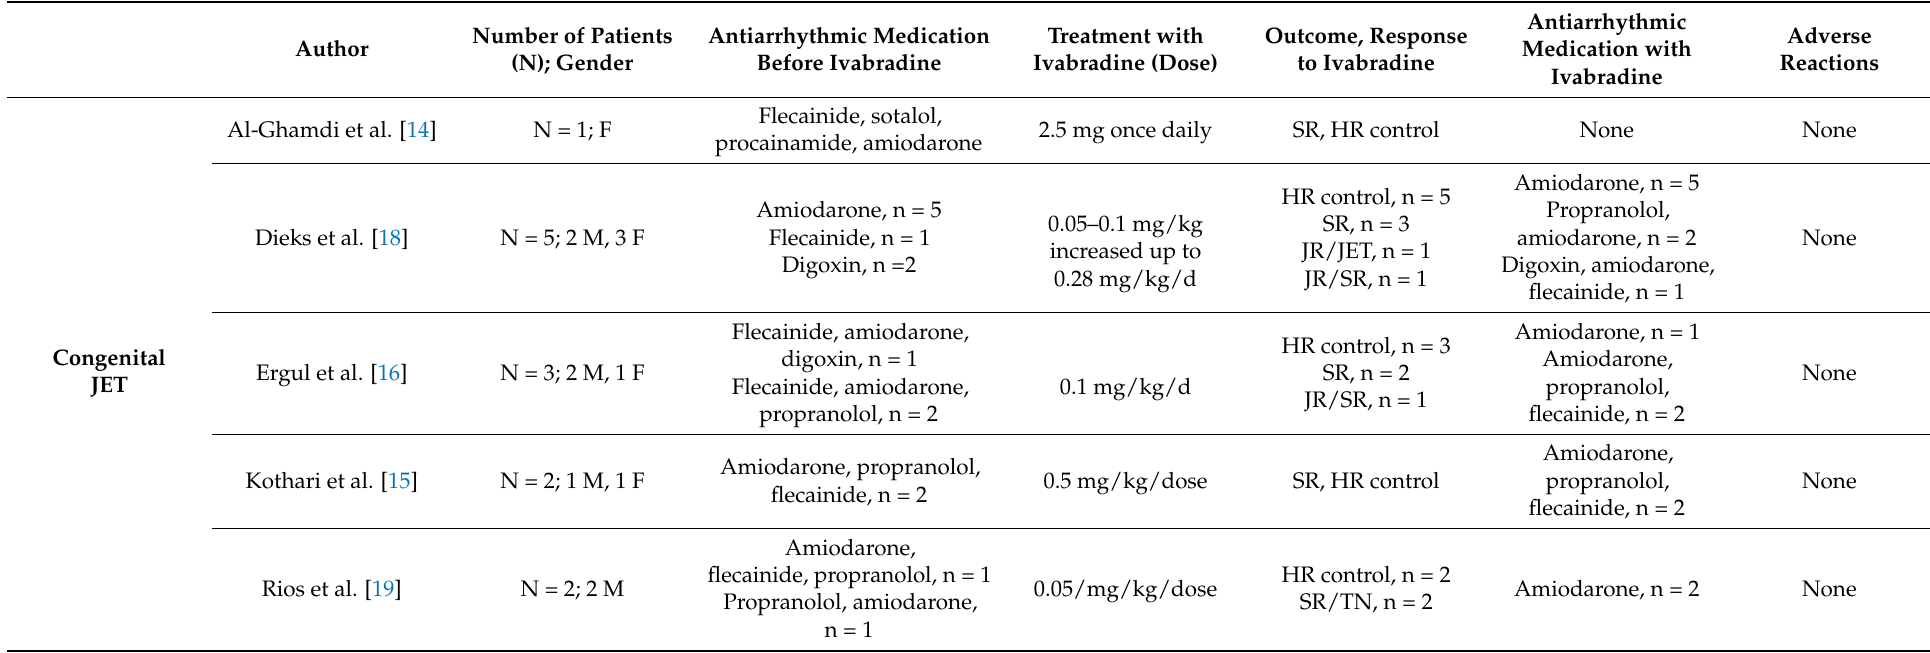
Table 1. Use of ivabradine in pediatric JET: review of the